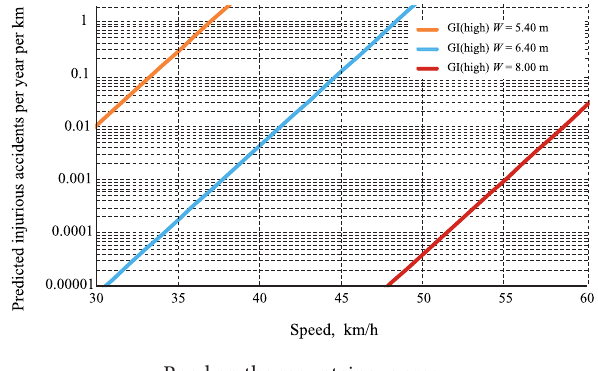
Road on the mountainous Fig. 2 . Abacus type for predicting the injurious crashes number per year per km